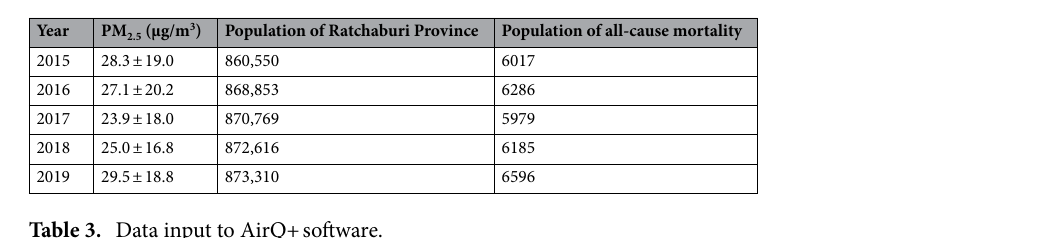
Table 3. Data input to AirQ+